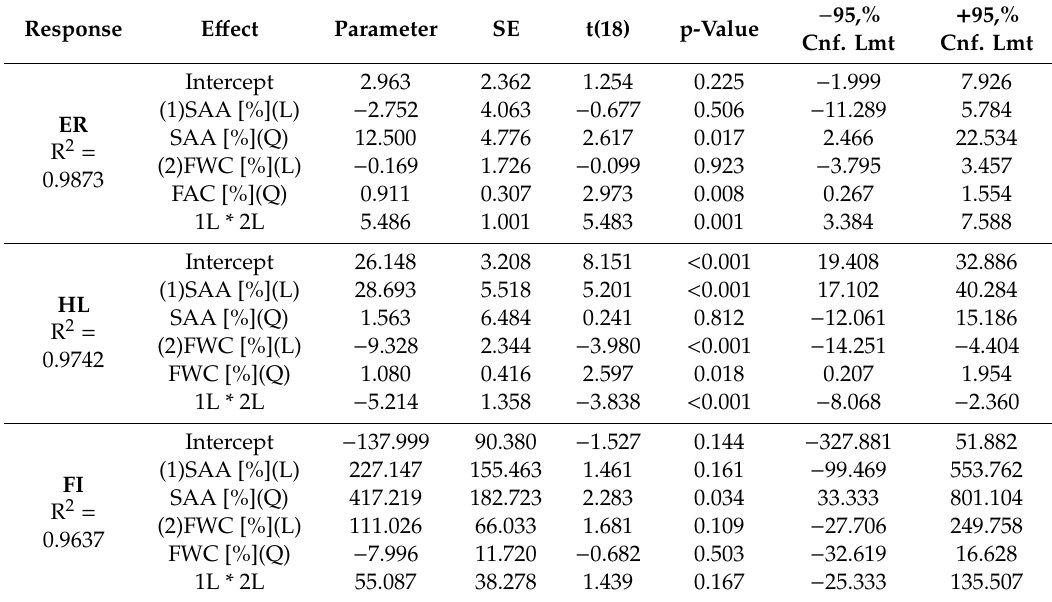
Table 11. Parameters of the model of the relationship between ER, HL, FI, and SAA quantity and FWC. Response